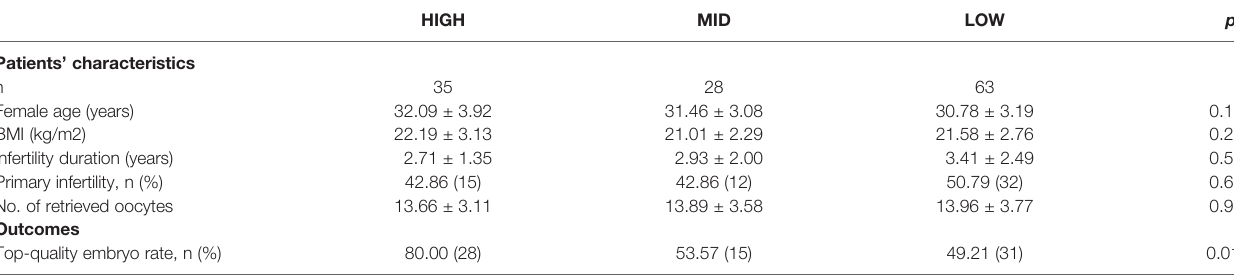
TABLE 2 | Relationship of GM-CSF concentration in SBCM with embryo